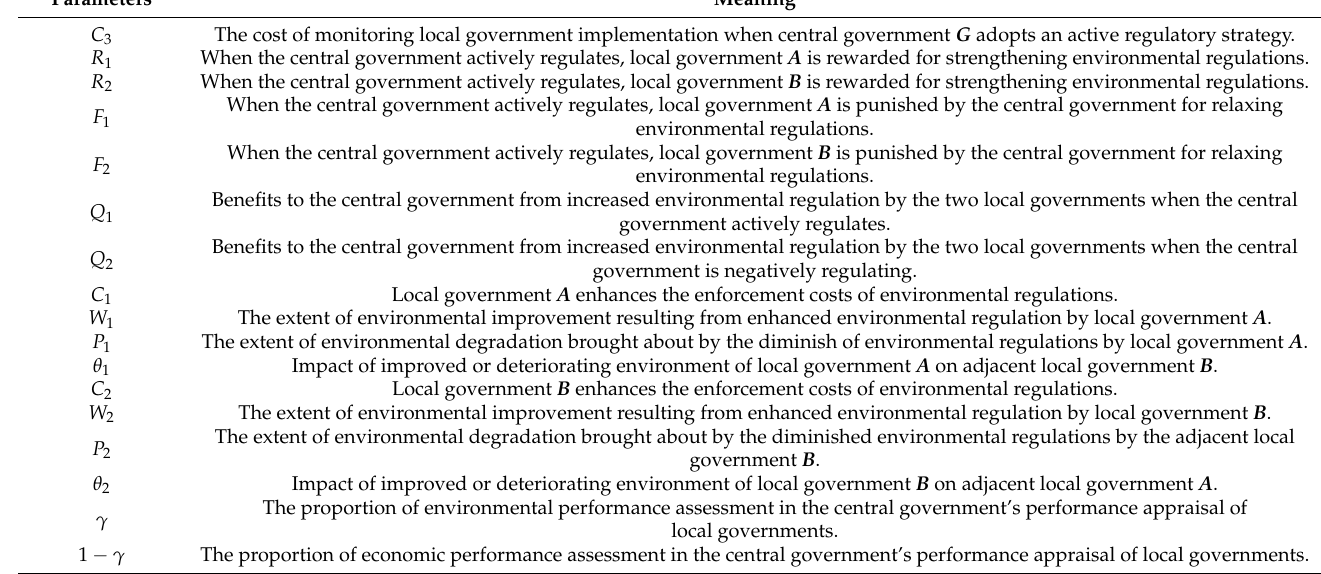
Table 1. Parameters of each subject of the three-party evolutionary game and their meanings.